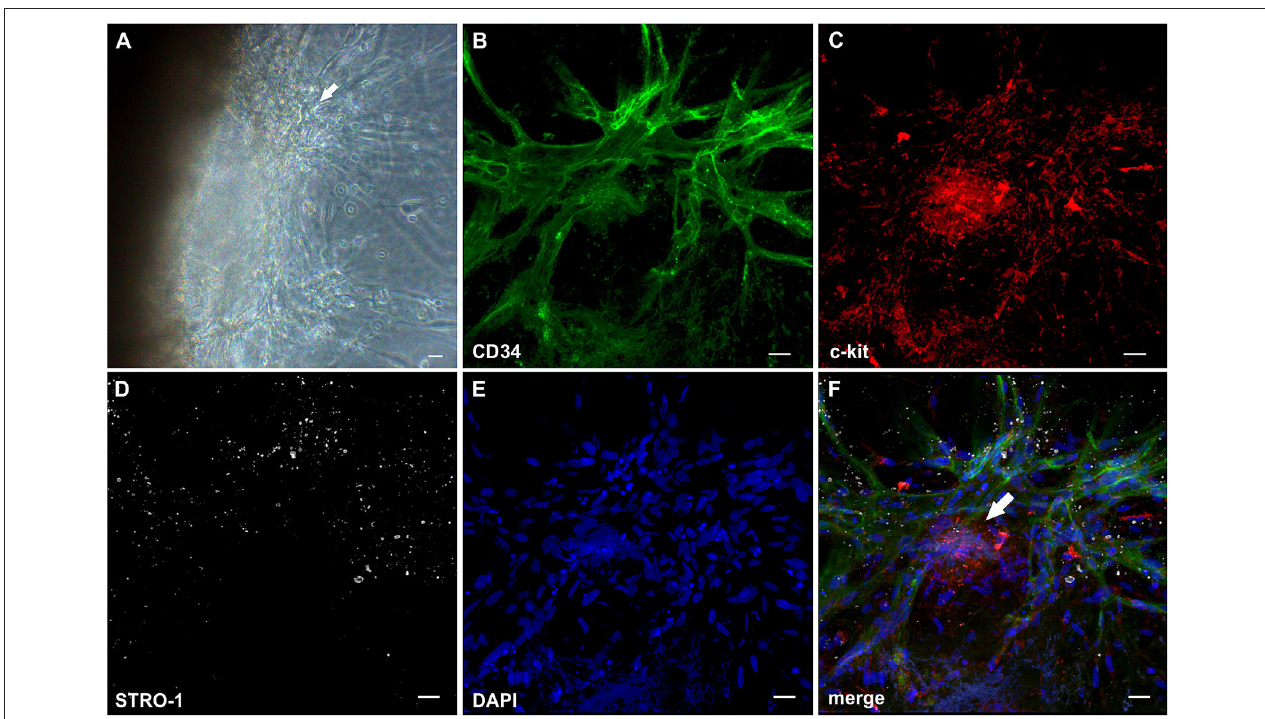
FIGURE 3 | Cell clusters within fibrin gels are an origin of neo-vessels formed by vasculogenesis. (A) Phase contrast microscopy image of a representative inflamed synovial tissue sample in 3D fibrin matrix on day 10 of culture, showing a cell cluster (arrow) external from the embedded tissue fragment in the fibrin gel with outgrowing elongated structures. The image was taken before IF staining. (B–F) CLSM images (collapsed 32 µ m-z-stack consisting of 20 consecutive images) showing the same cluster (arrow in F ) depicted in (A) . Both cluster and neo-vessels co-express (B) CD34 and (C) c-kit. (D) MSC marker STRO-1. (E) DAPI stain. (F) Merge. Scale bars, 20 µ